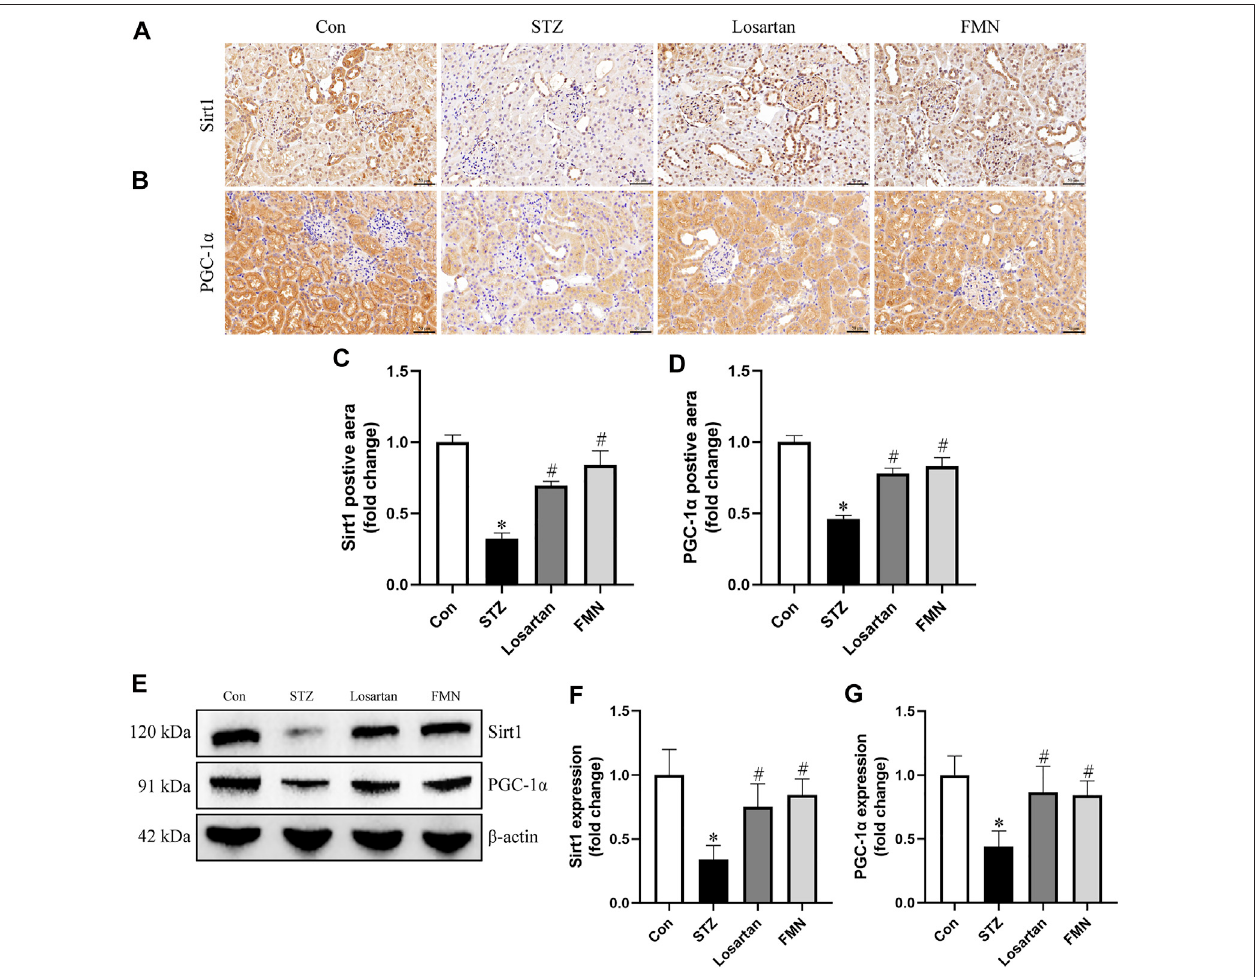
FIGURE 5 | FMN restored the Sirt1 and PGC-1 α expression in diabetic rats. (A – D) Representative photographs and semiquantitative analyses of immunohistochemistrystainingofSirt1andPGC-1 α (originalmagni fi cation×200,bars=50 µm). (E – G) RepresentativeWesternblotimagesofSirt1andPGC-1 α protein expression and semiquantitative analyses in different groups. Results were expressed as mean ± SD. * p < 0.05 vs. normal control rats. # p < 0.05 vs. STZ-induced diabetic